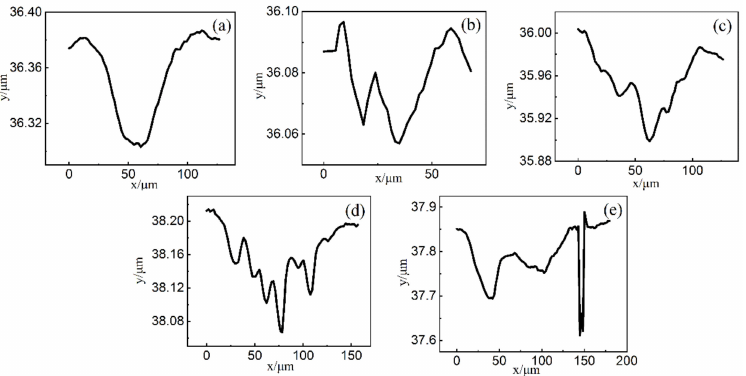
Figure 8. Cross-section profiles of different deposition pressure ( a ) 0.6 Pa, ( b ) 0.9 Pa, ( c ) 1.2 Pa, ( d ) 1.5 Pa, ( e ) 1.8 Pa.